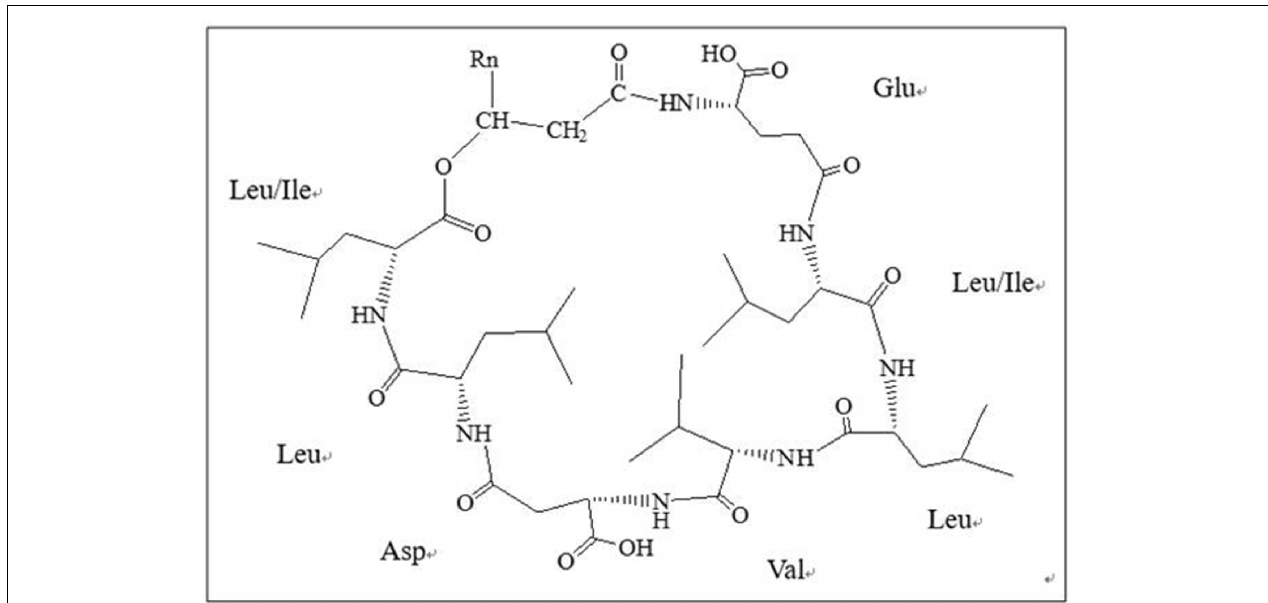
FIGURE 6 | Chemical structural formula of lipopeptides. This lipopeptide consisted of a β -fatty acid chain and a peptide chain, with condensation of the carboxyl at the end of fatty acid chain and the hydroxyl of Leu/Ile at the end of peptide.